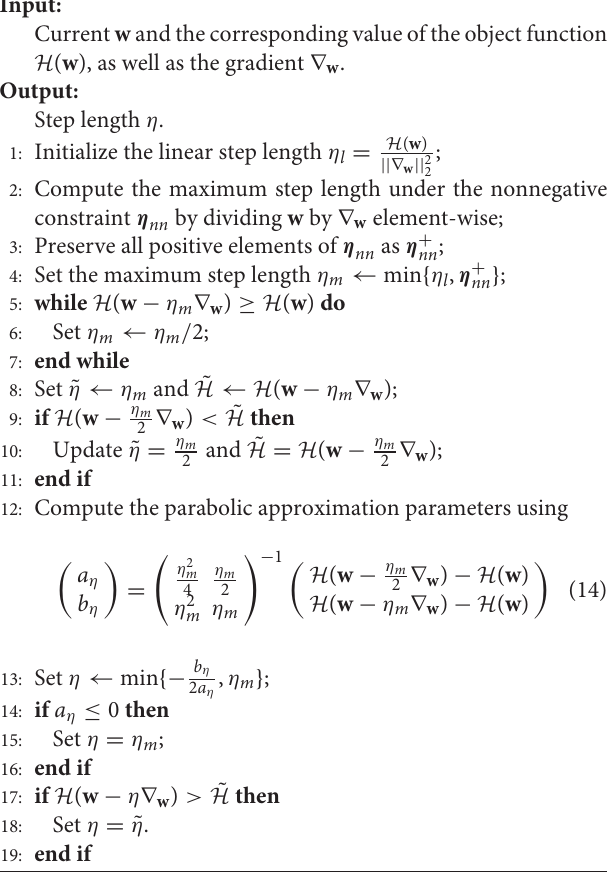
Algorithm 1 Algorithm to determine η in Equation (13)